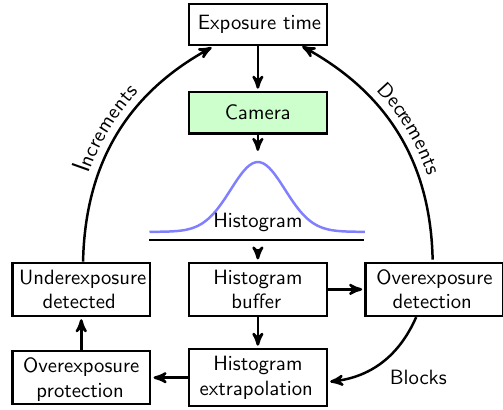
Figure A1. Overview of the automated exposure control